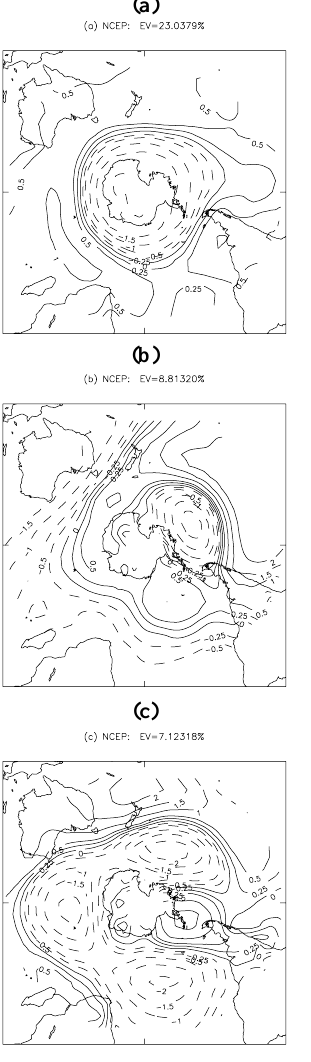
Fig. 5. The three leading EOFs from the 1971–2000 monthly mean NCEP SLP data. (a) SAM, (b) SPD and (c) W. The variation de- scribed by each EOF is also given in the figure title. Negative values are dashed and positive values are solid lines.